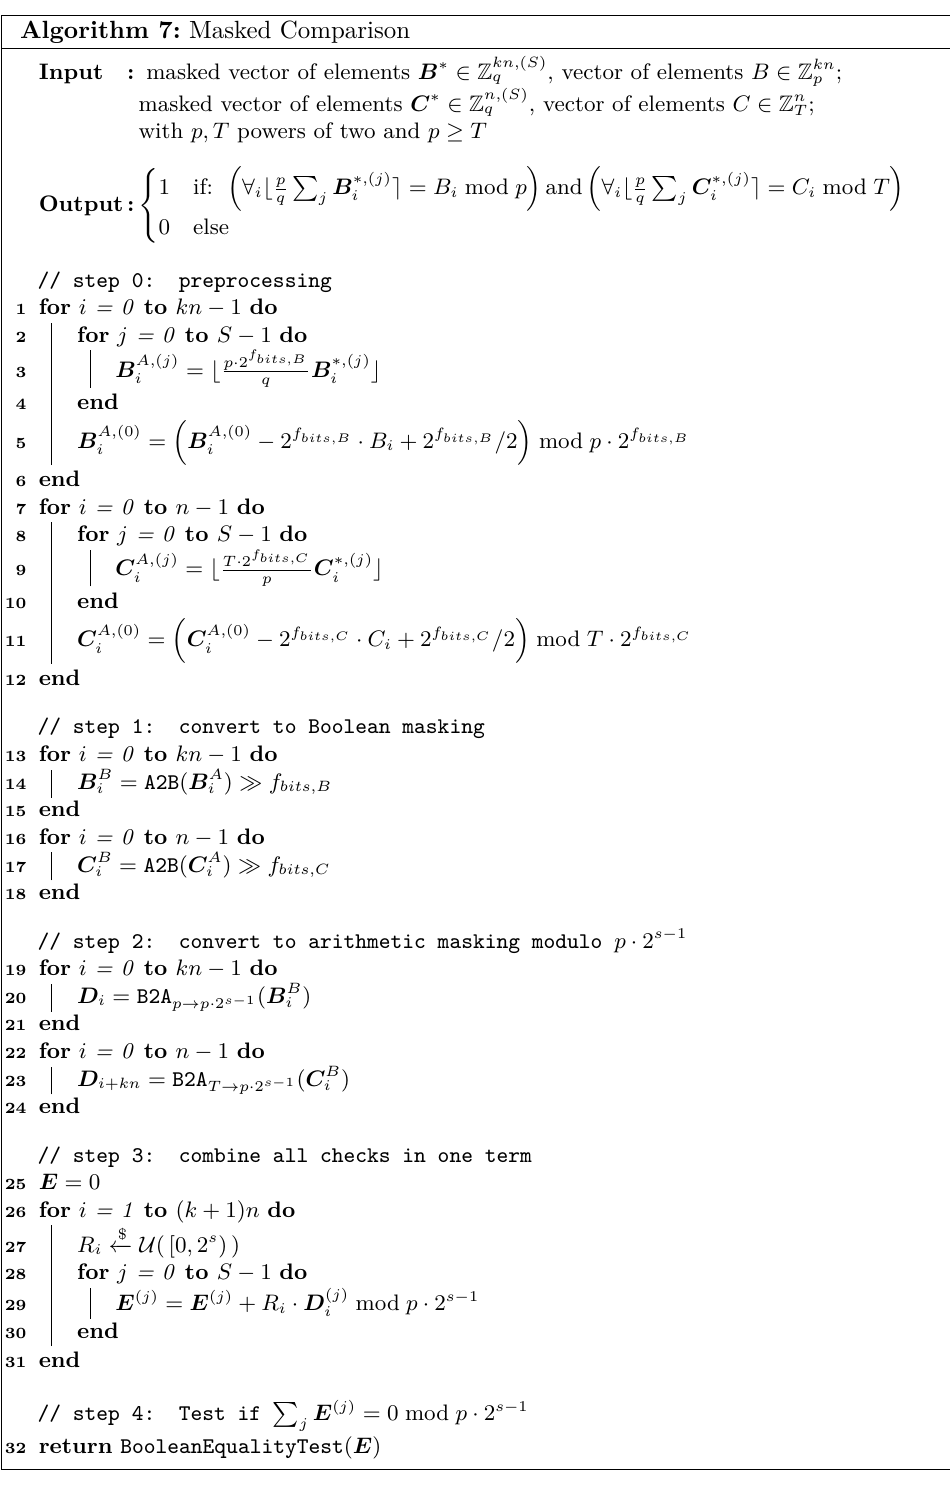
Algorithm 7: Masked